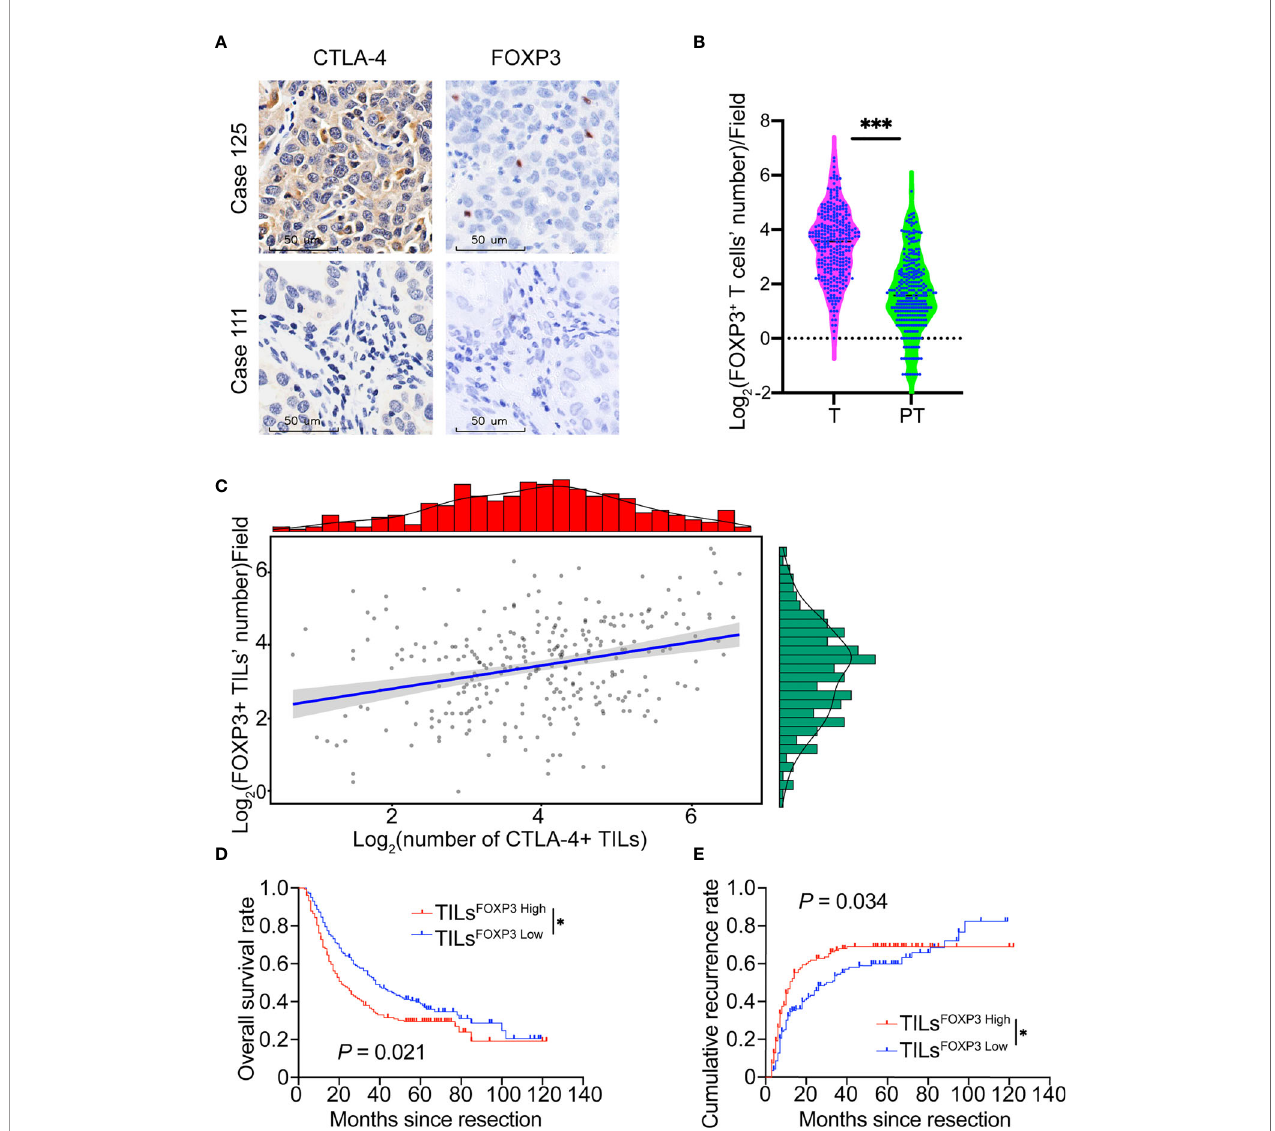
FIGURE 2 | FOXP3 expression and relationship with CTLA-4 in patients with ICC. (A) Representative staining of CTLA-4 and FOXP3 in ICC tumor samples (Case 125: patient with a high density of CTLA-4 + TILs and FOXP3 + TILs; Case 111: patient with low density of CTLA-4 + TILs and FOXP3 + TILs). Magni fi cation 400x. (B) Density of FOXP3 + in fi ltrating lymphocytes was higher in ICC tissues than paired adjacent normal liver tissues in the whole ICC cohort. (C) Positive correlation between the density of FOXP3 + TILs and CTLA-4 + TILs. (D, E) The Kaplan-Meier curve of OS and cumulative recurrence shows that patients with TILs FOXP3 High were associated with worse OS and a higher cumulative recurrence rate compared with patients with TILs FOXP3 Low . * P < 0.05 and *** P <